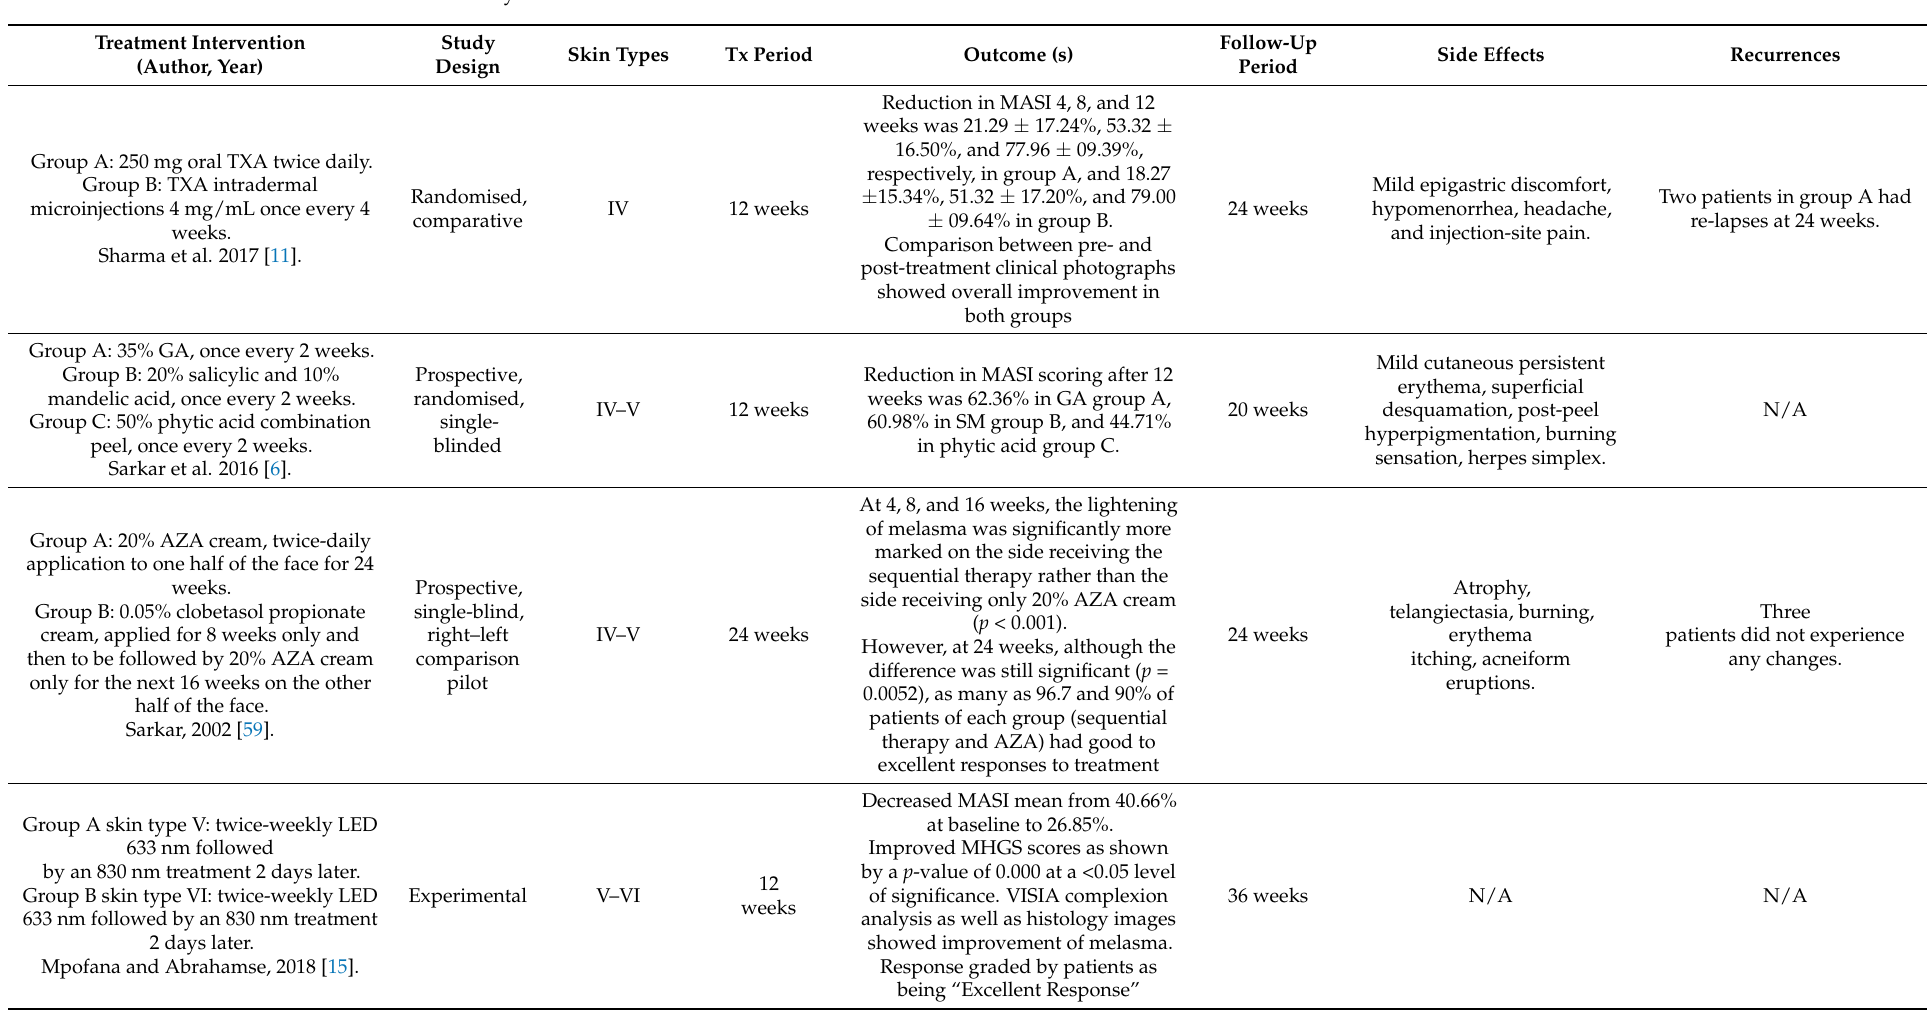
Table 4. Summary of included